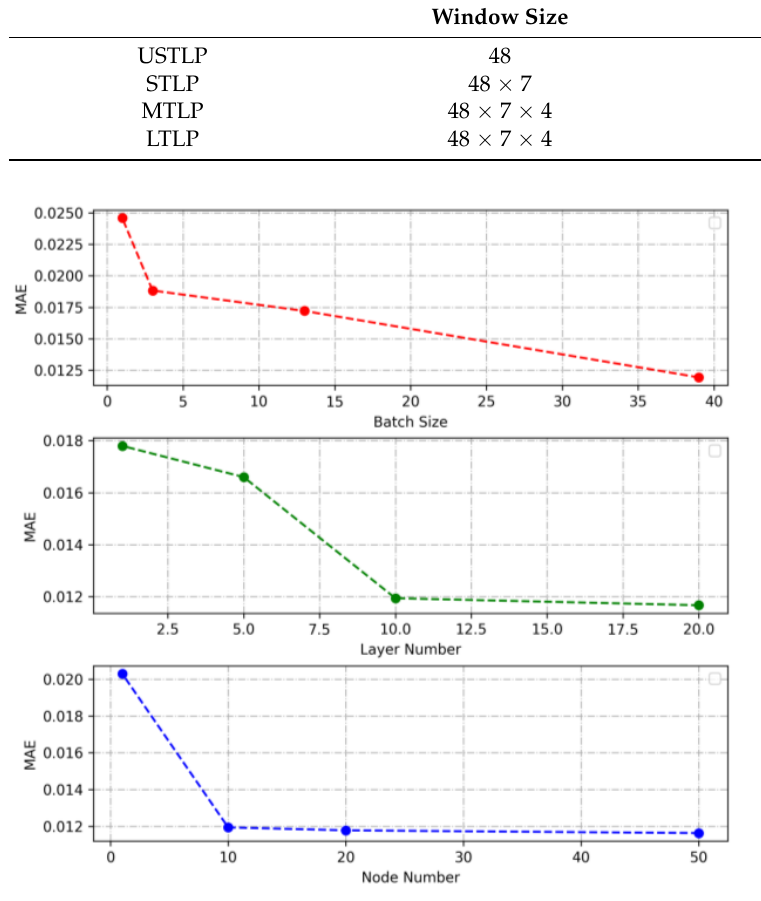
Figure 8. Tuning process of LSTM structure.